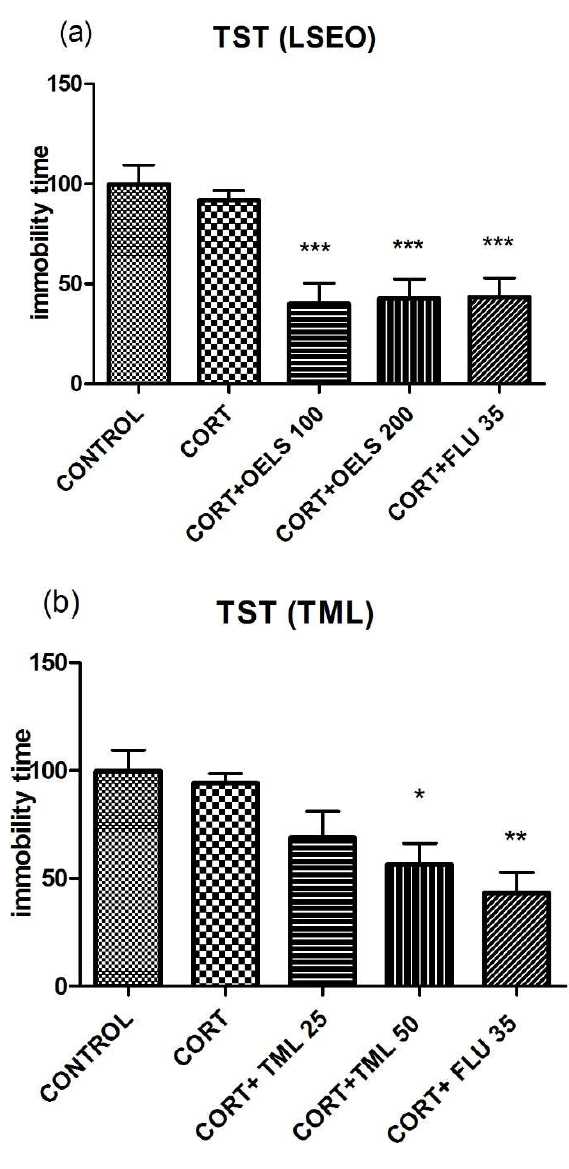
Figure 4. Effects of repeated administration of ( a ) LSEO (100 and 200 mg/kg; p.o.) and ( b ) TML (25 and 50 mg/kg; p.o.) in animals treated with CORT (22 days, 20 mg/kg, s.c.) on the immobility time, in seconds (s), on the TST. Values are expressed as the mean ± SEM ( n = 10). Statistical analysis was determined by one-way ANOVA followed by the Student-Newman-Keuls test. Significant values: * p < 0.05, ** p < 0,001, *** p < 0.0001 vs. CORT. LSEO = Lippia sidoides essential oil; TML =